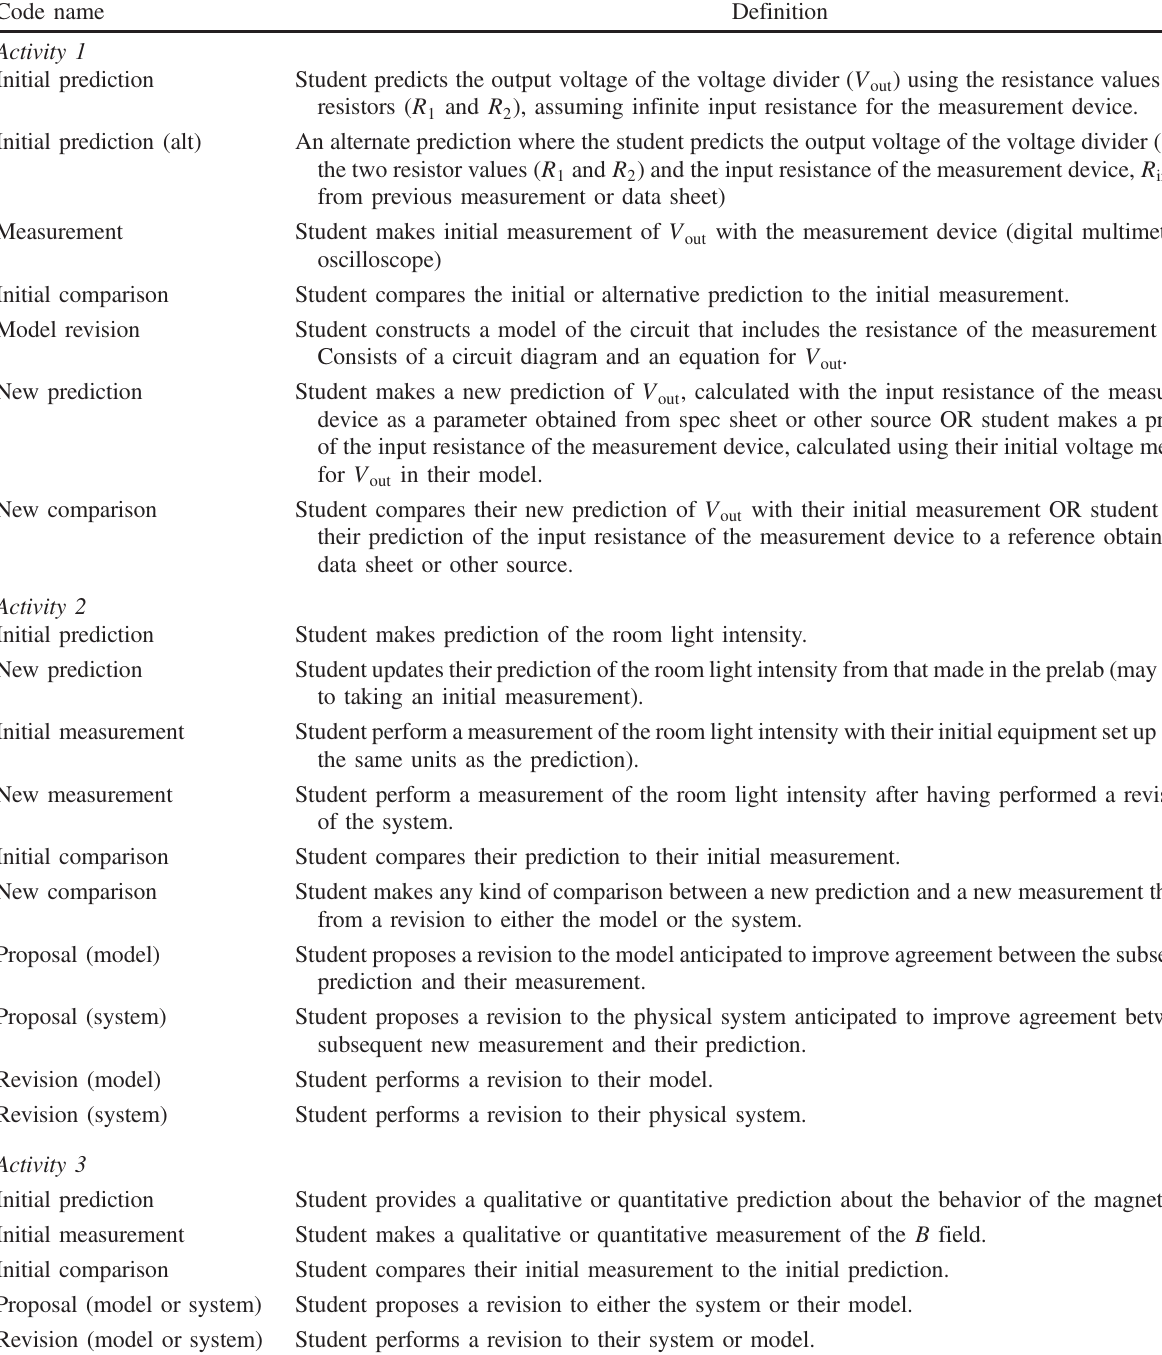
TABLE II. Finalized consensus codes for all three activities that were the result of the coding process described in Sec. IV B. The Activity 1 codes were used for both the 1 and 10 M Ω resistor voltage divider circuits. Note the similarity of the codes for each activity — all three activities included prediction, measurement, comparison, and revision codes. Since the revision pathway in Activity 1 was constrained by the lab guide, there exists only one revision code (i.e., model revision) and no codes for proposals. The code sets for Activities 2 and 3 contain proposal codes, as well as revision codes for multiple pathways due to their open-ended nature. These proposal and revision codes are the only codes in this table that have associated subcodes describing the specific types of proposals and revisions students performed (discussed in Secs. VI B and VI